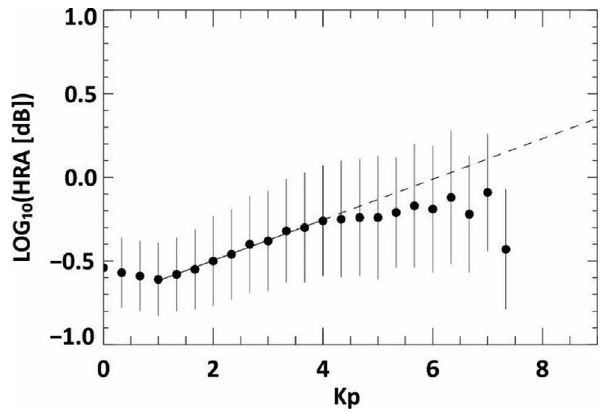
Fig. 6. Maximum hourly range of auroral absorption (HRA) versus Kp index binned in increments of 1/3 Kp. Filled circles and vertical lines indicate the mean and standard deviation of the HRA. Based on Fiori et al.